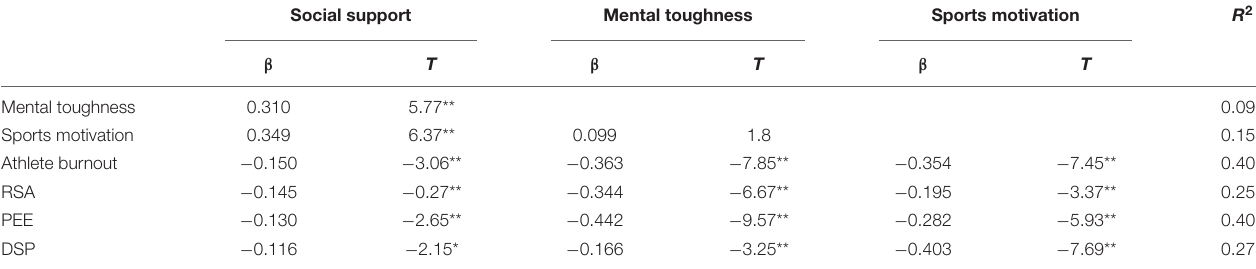
TABLE 4 | Regression analysis of social support, sports motivation, mental toughness, and athlete burnout in weightlifters. Social support